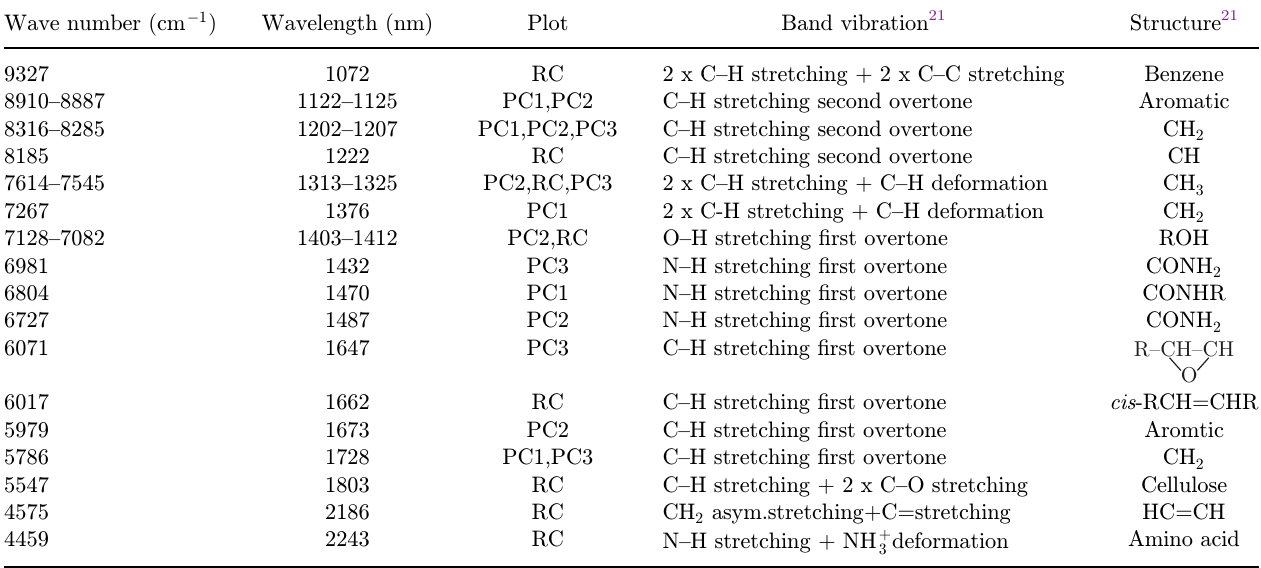
Table 2. The absorption bands (from regression coe±cient and X-loading weight) with predominantly a®ected the prediction model of DRW (%) in MHR using partial least square